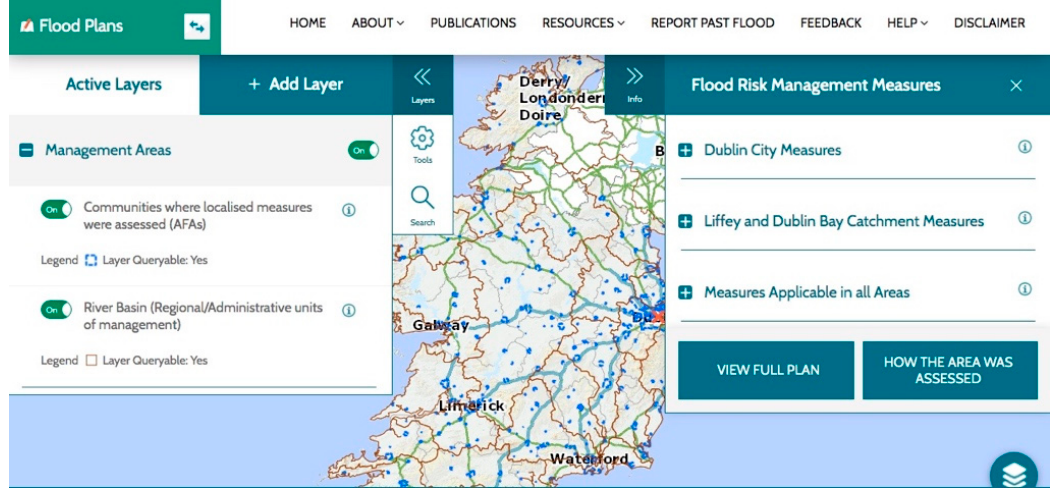
Figure 5. Example of the Flood Plans tool provided by the Irish National Flood Mapping Website.